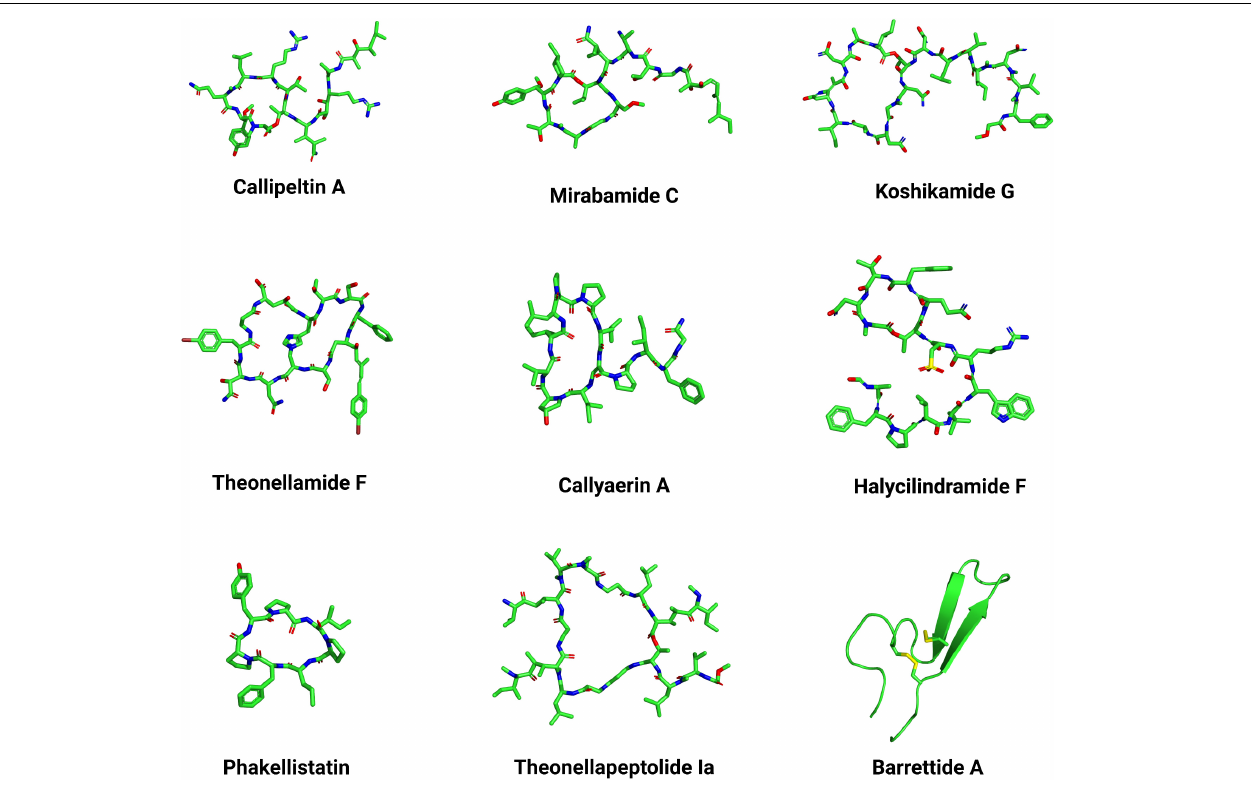
FIGURE 4 | Three-dimensional structures of Porifera peptides. Representative structures with different scaffolds were selected based on the Porifera peptide classes described in the main text, including callipetin A (PubChem ID: 70678682), mirabamide C (PubChem ID: 24179849), koshikamide G (PubChem ID: 101518086), theonellamide F (PubChem ID: 45382310), callyaerin A (PubChem ID: 52941212), halycilindramide F (PubChem ID: 132596267), phakellistatin (PubChem ID: 11765991), theonellapeptolide Ia (PubChem ID: 101601088), and barrettide A (PDB ID: 6CFB). The PubChem.sdf files were parameterized using Maestro v. 11.6.013 (Schrodinger) and further visualized on PyMOL v. 1.8. The three-dimensional structure images were generated on PyMOL v.